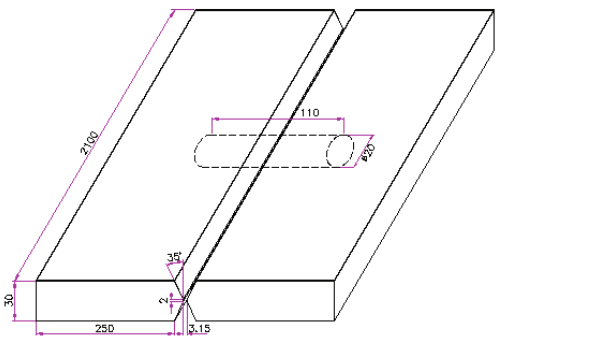
Figure 2. Weld pad configuration for weld joint specimens.